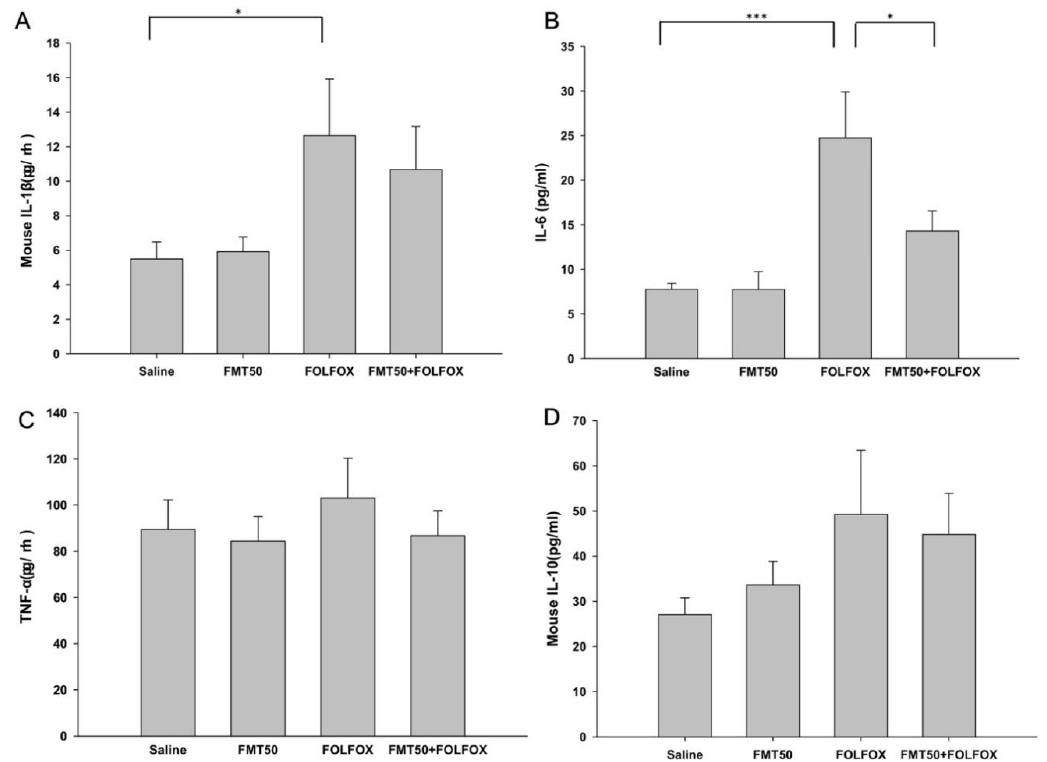
Figure 6. Serum protein levels of ( A ) interleukin-1β (Il-1β), ( B ) Il-6, ( C ) tumor necrosis factor-α (TNF-α), and ( D ) Il-10 in subcutaneously injected colorectal carcinoma mice exhibiting FOLFOX-induced intestinal damage with/without FMT ( n = 6 for each group). FMT50: 50 mg/mL. Values are presented as the mean ± SEM. *: p < 0.05, ***: p < 0.001.